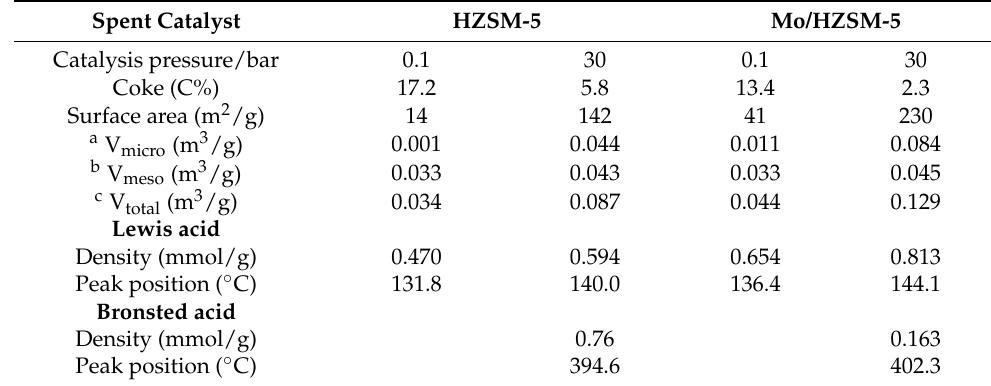
Table 2. Summary of texture properties and acidity of spent